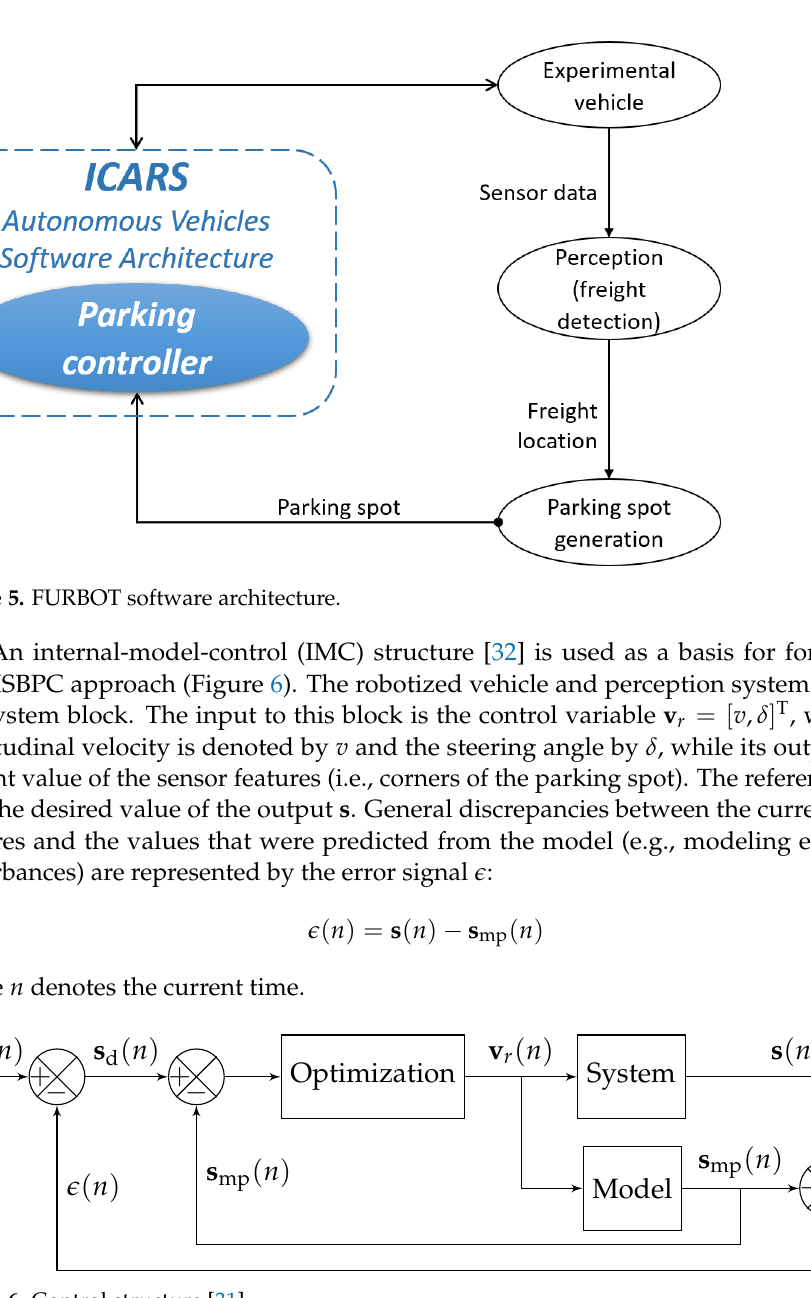
Figure 6. Control structure